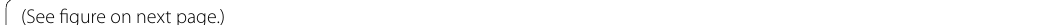
figure on next Fig. 2 Bacterial genus‑level compositions of the control and Enterococcus faecium SROD‑supplemented rumen fermenta. The data portray genus‑level 16S rRNA pyrotagged gene sequences. Sequences were classified using the RDP naive Bayesian rRNA Classifier with an 80% confidence threshold. The minor group in the panel is composed of genera with a percentage of reads < 0.4% of the total reads in all